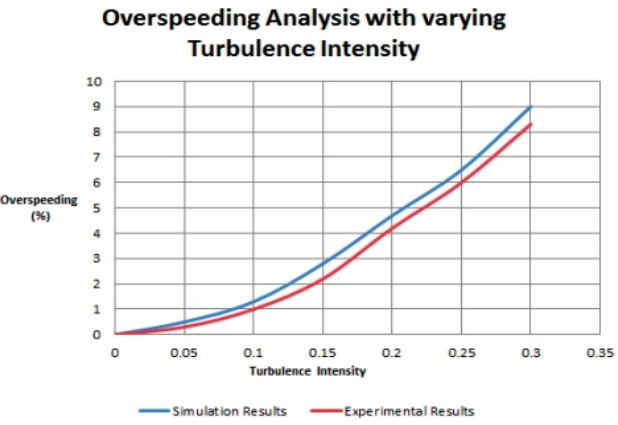
Figure 8. Turbulence intensity vs. overspeeding.